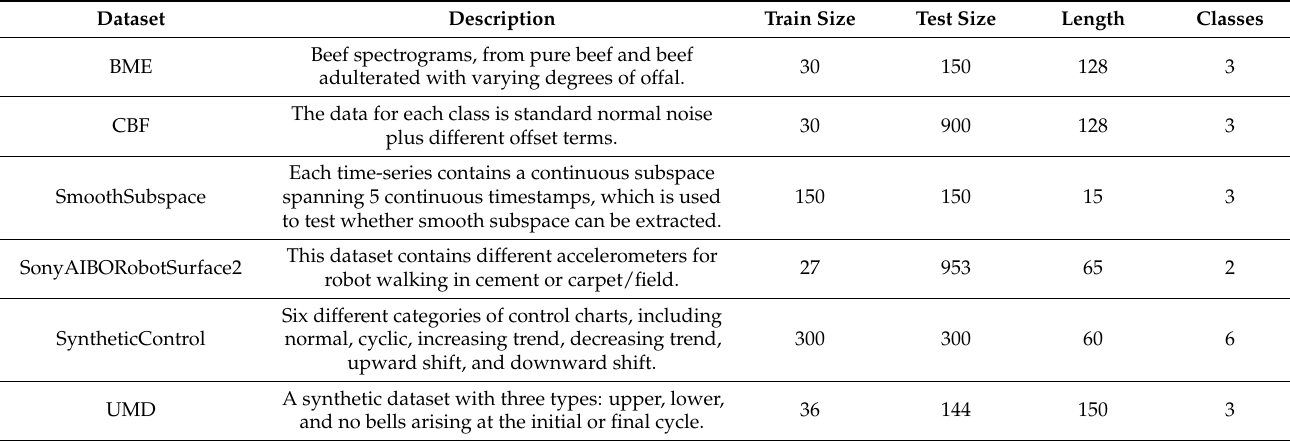
Table 1. Description of